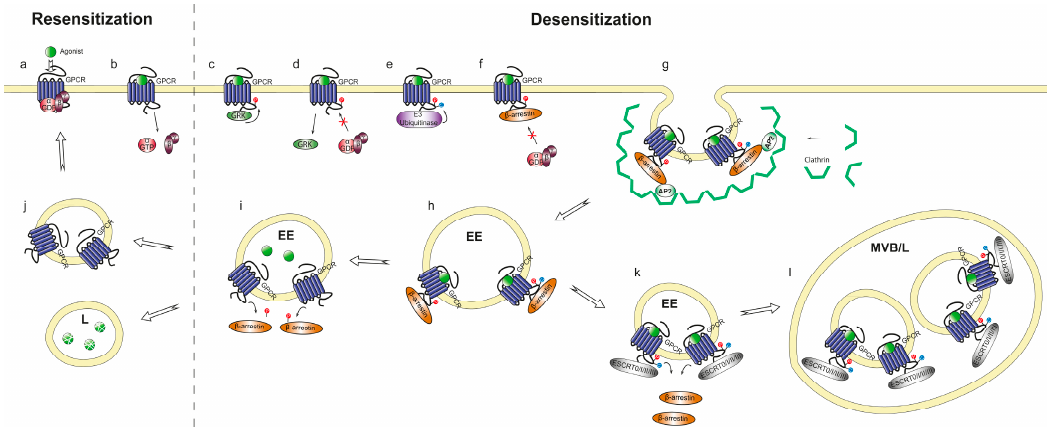
Figure 1. Overview of the different pathways of chemotaxis receptor adaptation and regulation. ( a ) Agonist binding; ( b ) Dissociation of heterotrimeric G proteins; ( c ) GPCR phosphorylation by GRK’s; ( d ) Reduced affinity for heterotrimeric G proteins due to phosphorylation; ( e ) Ubiquitination of the receptor, tagging it for the degradation pathway; ( f ) β -arrestin binds phosphorylated receptors and reduces receptor affinity for heterotrimeric G proteins; ( g ) Interaction of β -arrestin with β 2 adaptin (AP2) and clathrin creates clathrin coated pits, essential for receptor internalization; ( h ) Endocytosis of receptors and agonists into early endosome (EE); ( i ) The pH in the endosomes drops, resulting in disassociation of the receptor and ligand; ( j ) Receptors are recycled to the membrane while the ligands are degraded in lysosomes (L); ( k ) In the degradation pathway, the ubiquitin tag is detected by the ESCRT proteins; ( l ) The ESCRT proteins target the receptor sequentially to the early endosomes, late endosomes, multivesicular bodies (MVB) and eventually to lysosomes where both the receptor and ligand are degraded.